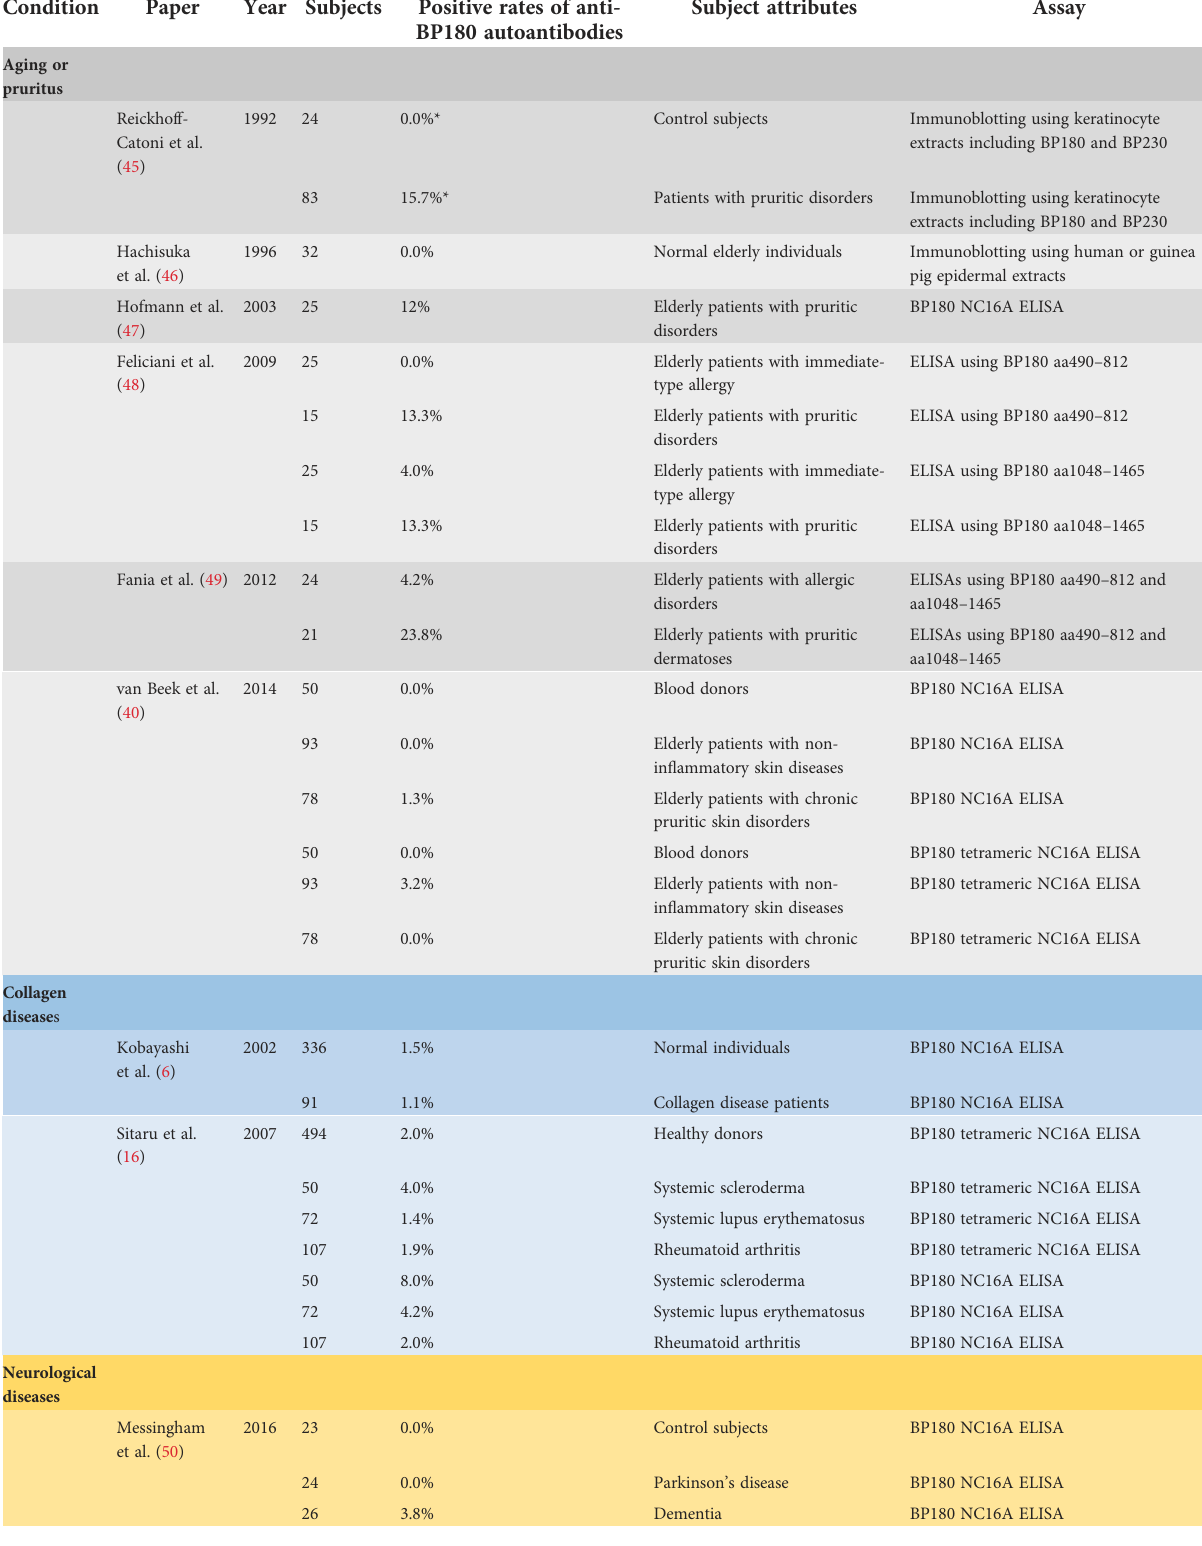
TABLE 2 The prevalences of anti-BP180 autoantibodies in patients with various medical